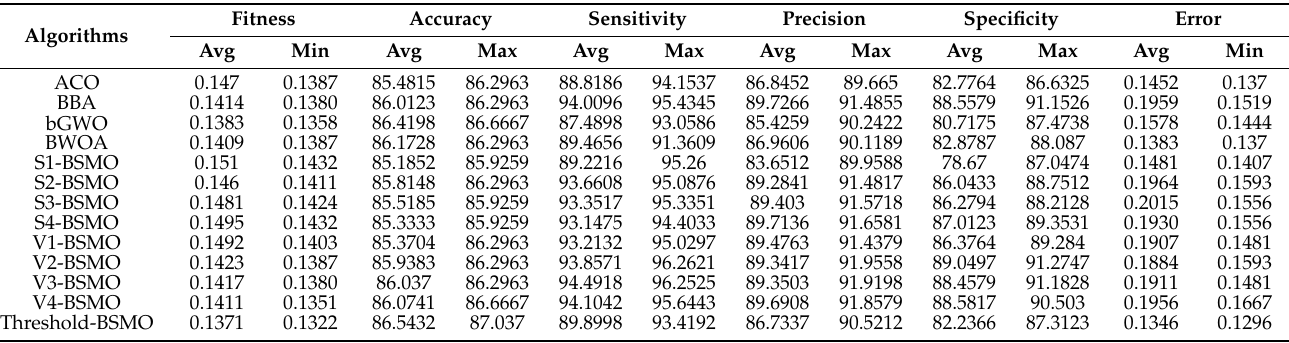
Table 4. Heart disease